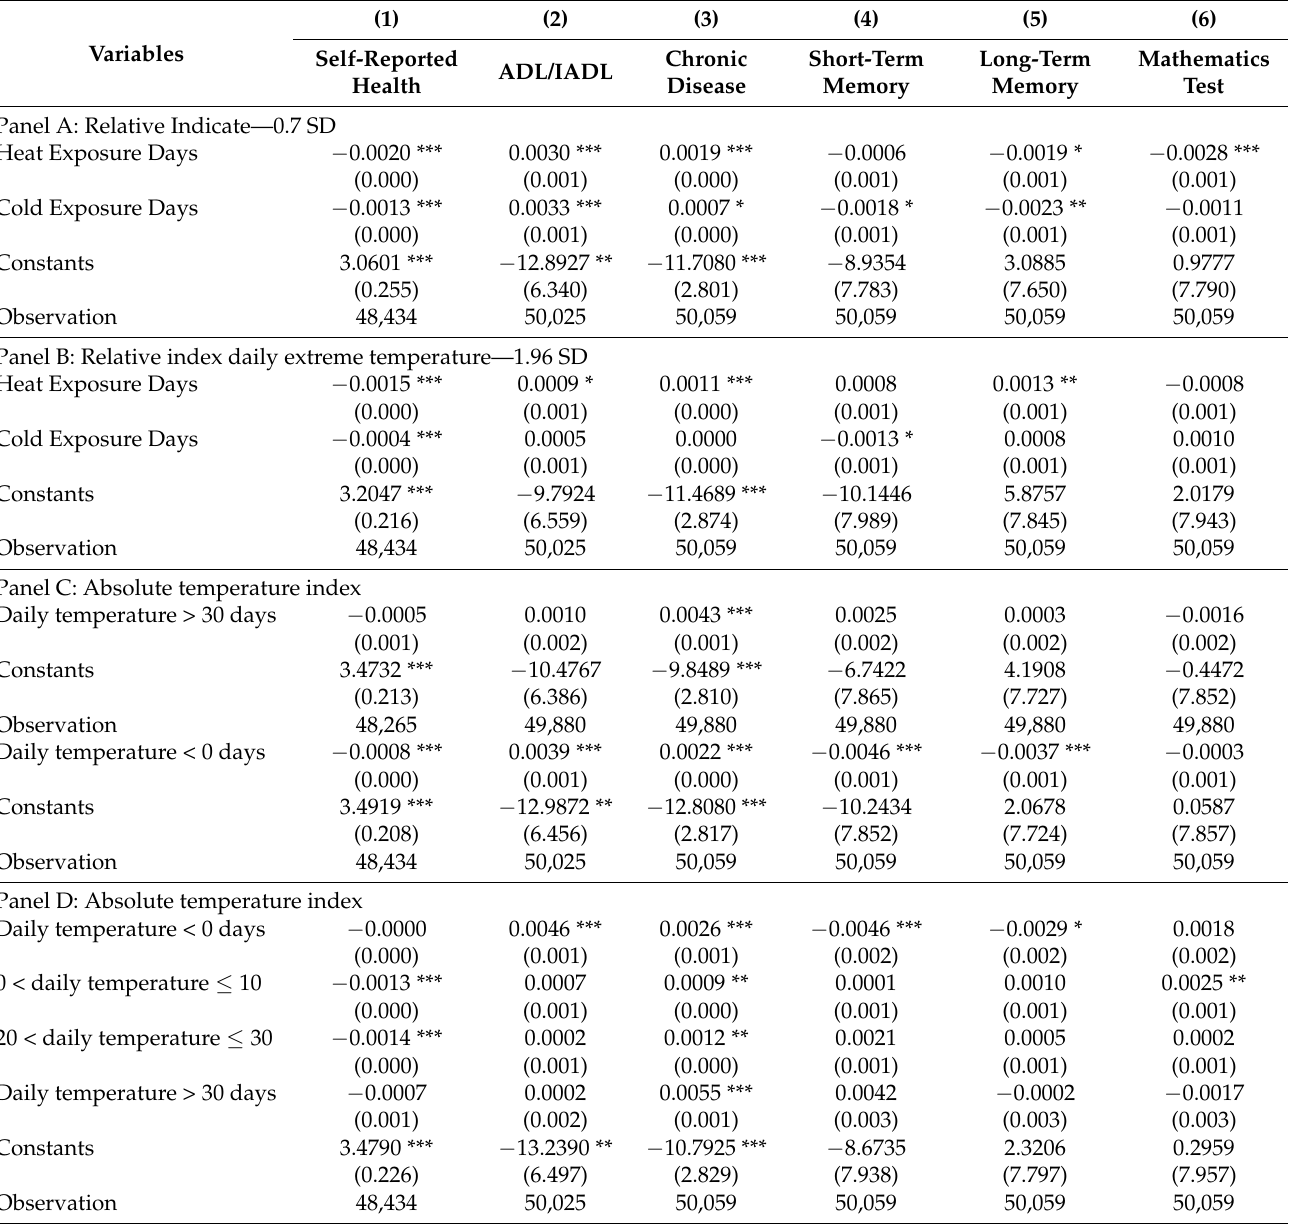
Table 5. Robustness test